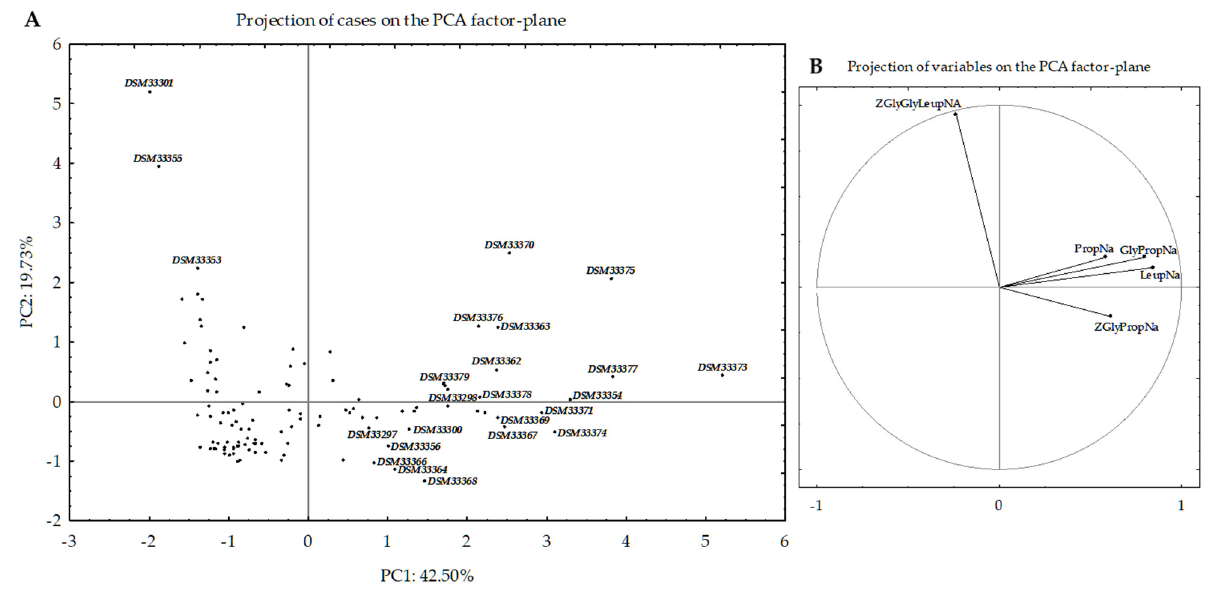
Figure 2. Score ( A ) and loading ( B ) plots of the first and second principal components (PC) after principal component analysis (PCA) based on the general aminopeptidase type N (PepN), proline iminopeptidase (PepI), X-prolyl dipeptidyl aminopeptidase (PepX), endopeptidase (PepO), and prolyl endopeptidase (PepP) activities of the cytoplasmic extracts of the 131 Bacillus , lactobacilli, and Weissella strains. PepN, PepI, PepX, and PepP were measured using Leu-p-nitroanilides (p-NA), Pro-p-NA, Gly-Pro-p-NA, Z-Gly-Gly-Leu-p-NA, and Z-Gly-Pro-4-nitroanilide substrates, respectively. All strains are reported in the plot by circles and the strain code was reported only for the selected strains.